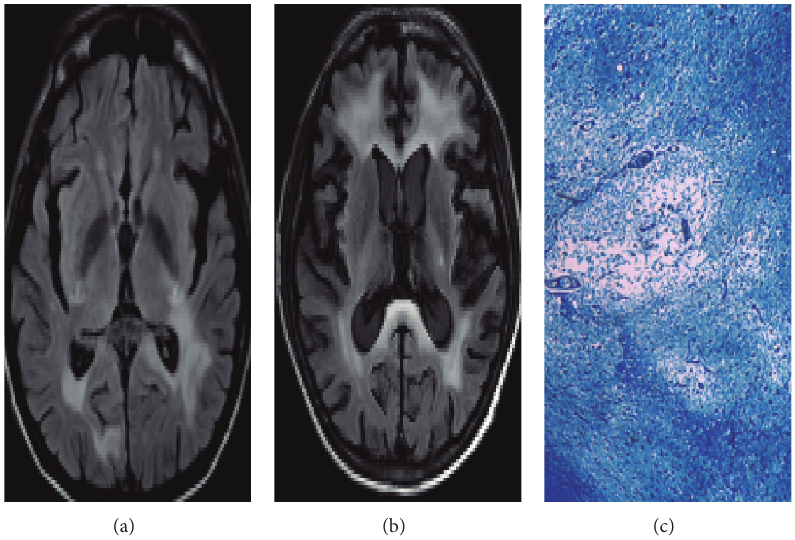
Figure 1: Sequential MRI of the brain and myelin stain. Axial FLAIR images show hyperintensity in patches of subcortical white matter localized in parietal and occipital lobes (a). Premortem axial FLAIR images show increased lesions in bilateral frontal lobes without mass effect after treatment with maraviroc (b). Kluver-Barrera stain (10x) for myelin revealed brainstem zones of demyelination and enlarged oligodendrocytes with hyperchromatic nuclei and bizarre astrocytes